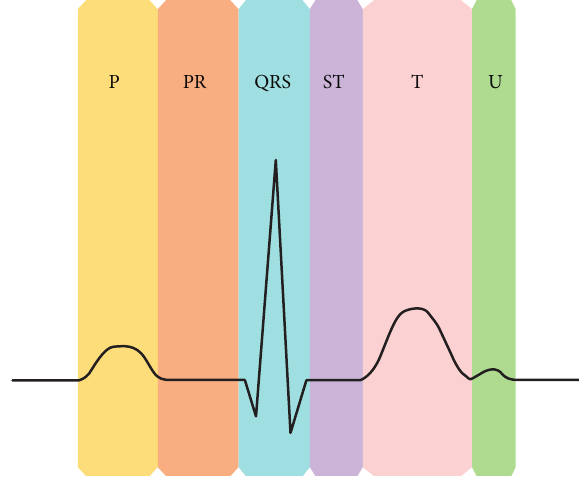
Figure 1: A complete ECG signal.